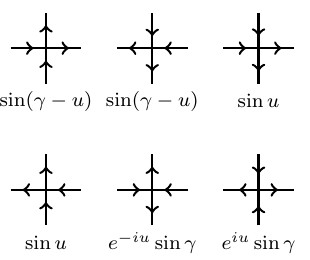
Figure 1 . The six vertices and their Boltzmann weights.